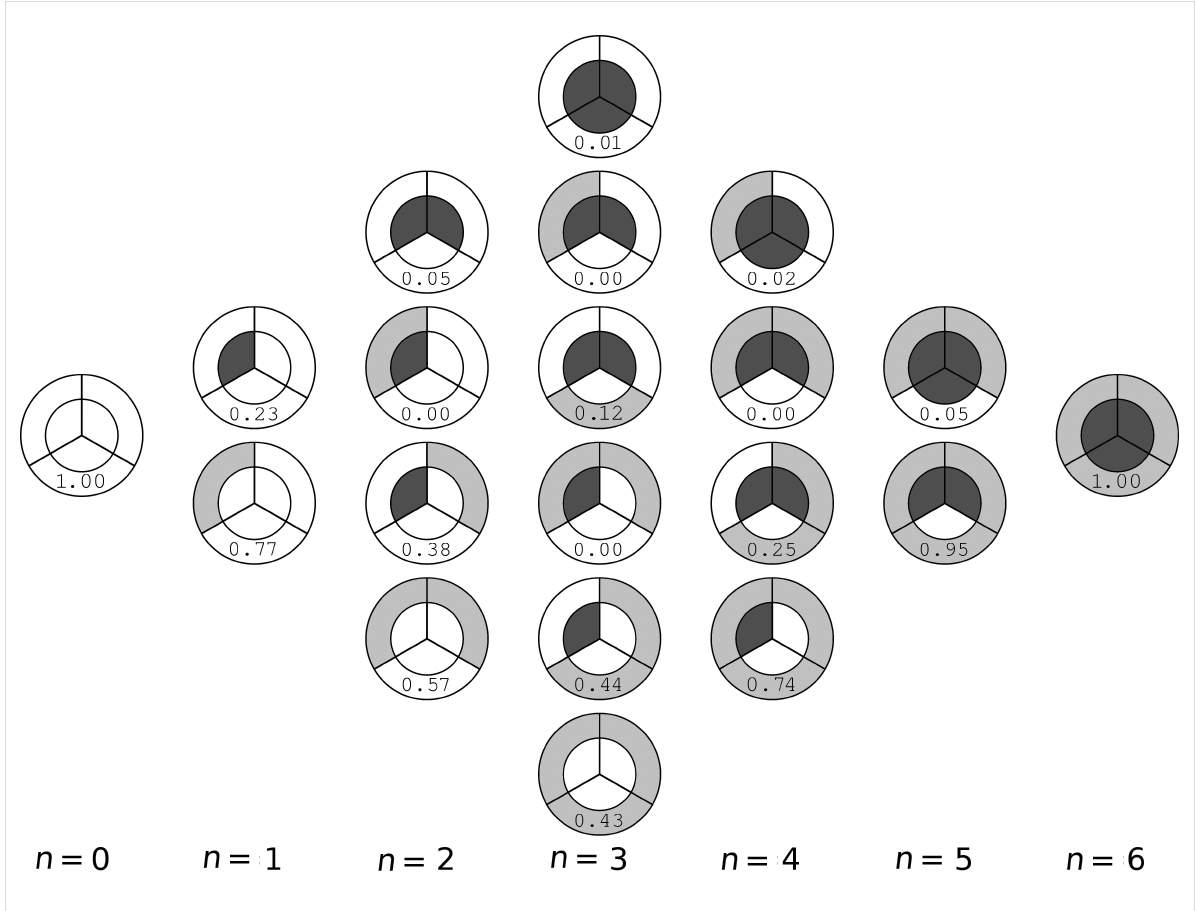
Figure 3: Diagram representing the population of all microstates at each number of titrable protons ( n ) present in the molecule.